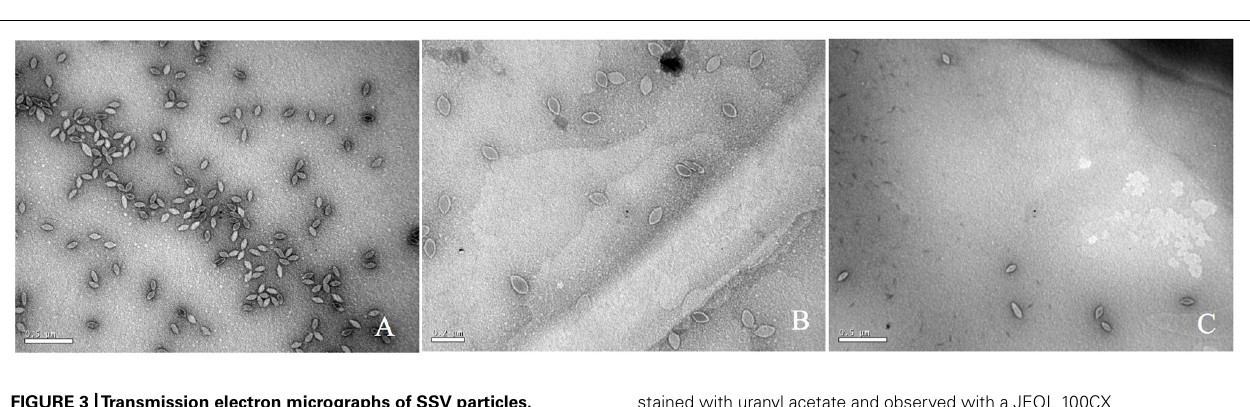
stained with uranyl acetate and observed with a JEOL 100CX transmission electron microscope. Bar represents 0.2 μ m (B) or 0.5 μ m (A,C)